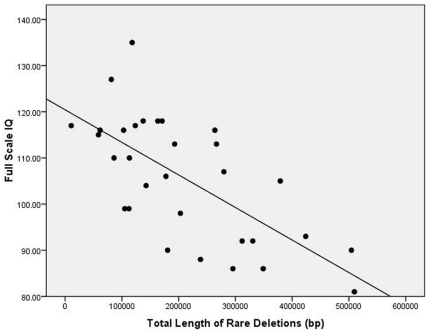
Scatterplot of the relationship between length of total rare deletions (base pairs) and Full Scale Intelligence Quotient in the Anglo/White group (r = −.68, p<.001).